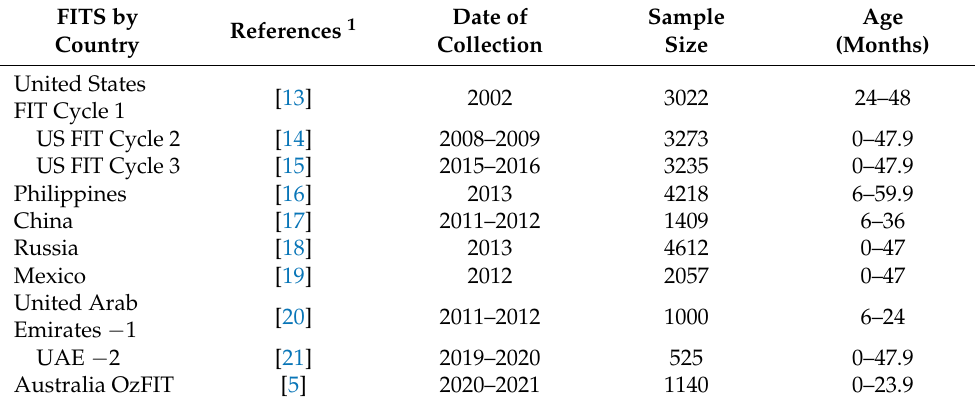
Table 1. Published Feeding Infants and Toddlers Studies (FITS) by country and